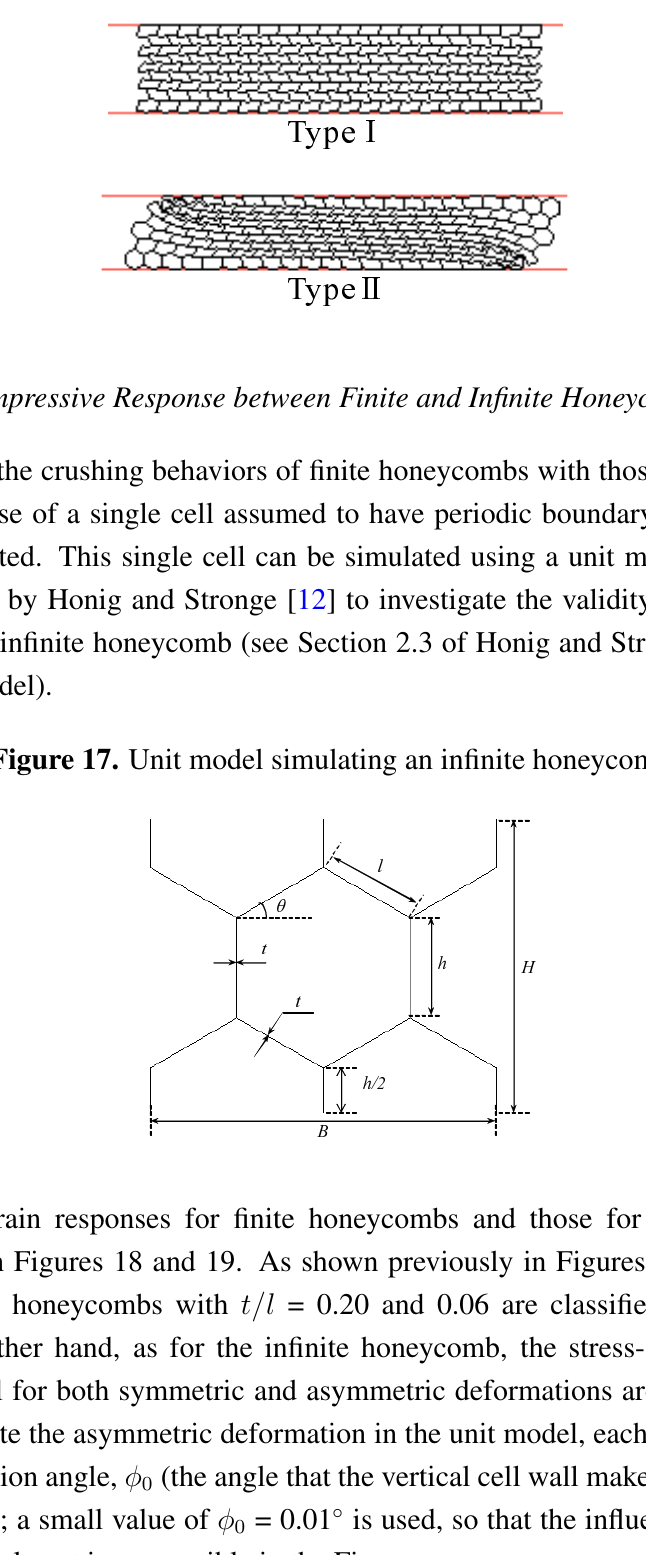
Figure 16. Deformed shapes of the t - t - 2 t model in process (d) shown in Figures 4 and 5.